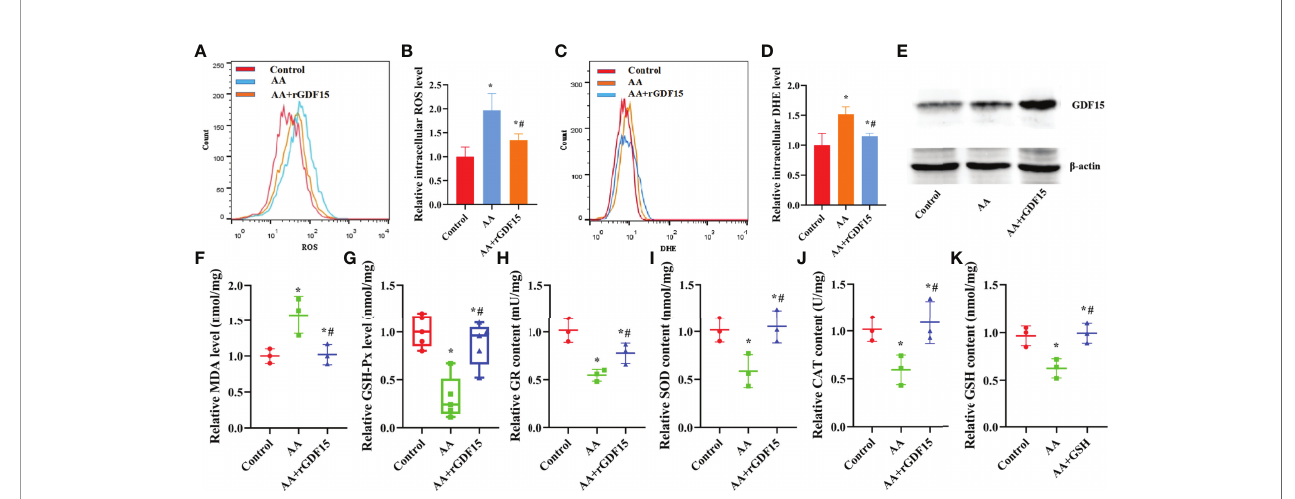
FIGURE 7 | The supplementation of exogenous rGDF15 restored antioxidant capability of KGN cells caused by AA. (A – D) Pretreatment of rGDF15 reduced the levels of ROS and O 2- levels in KGN cells. (E) The supplementation of rGDF15 increased the level of GDF15 protein after exposed to AA. (F – K) Exogenous supplementation of rGDF15 reduced the levels of MDA and restored the activities of antioxidant enzymes SOD, CAT, GSH-Px and GR in KGN cells and advanced the GSH content caused by AA. Data represent mean ± standard error, *P < 0.05, * # P <